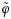
Modeling results in source space with best fitting forgetting-parameter values.Red: Predictive surprise (PS), Green: Bayesian surprise (BS), Blue: Confidence-corrected surprise (CS) A) Colored areas depict protected exceedance probabilities (φ˜) of the surprise readout functions of the Dirichlet-Categorical TP1 model within the dipoles S1P50, right S2 (RS2) and left S2 (LS2) using alpha blending. In grey shaded areas the DC model family shows φ < 0.99 or the TP1 model family φ < 0.95. The S1N20 dipole was omitted in the visualization as no model is observed above this threshold. Magenta horizontal lines indicate φ˜=0.95. Line plots above each dipole plot show the respective mean percent variance explained of the models in dotted rectangles ± standard error. B) The group log model evidence (GLME) values corresponding to the stimulus half-lives for forgetting-parameter τ, after averaging the timebins inside the dotted-rectangles (S1P50: 145-191ms; RS2: 68-143ms; LS2: 76-168ms). The grey lines indicate a difference of 20 GLME from the peak, indicating very strong evidence in favour of the peak half-life value compared to values below this threshold.